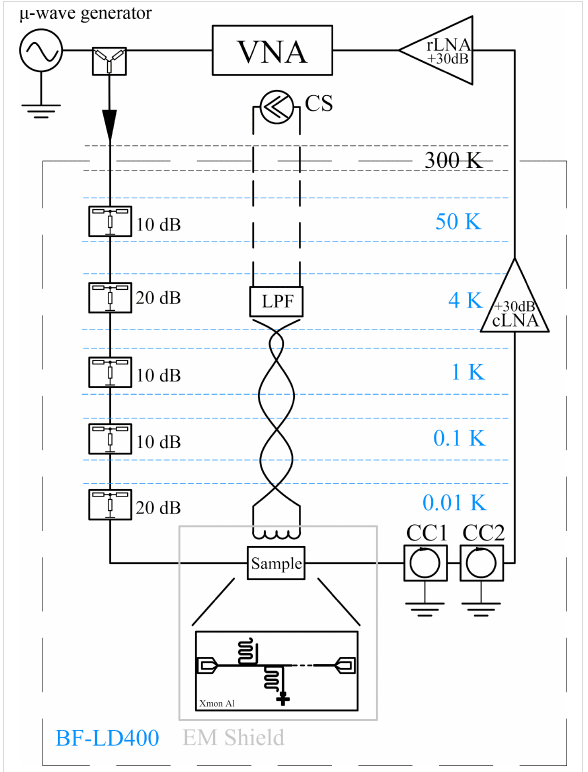
Figure 5: The X-mon qubit measurement setup. The implemented amplifier is marked as cLNA and the room-temperature amplifier is marked as rLNA. CC1 and CC2 are cryogenic circulators with 50 Ω termination (LPF: low-pass filter for the superconducting coil line, CS: high-precision current source). The following setup was installed in a BlueFors BF-LD400 dilution